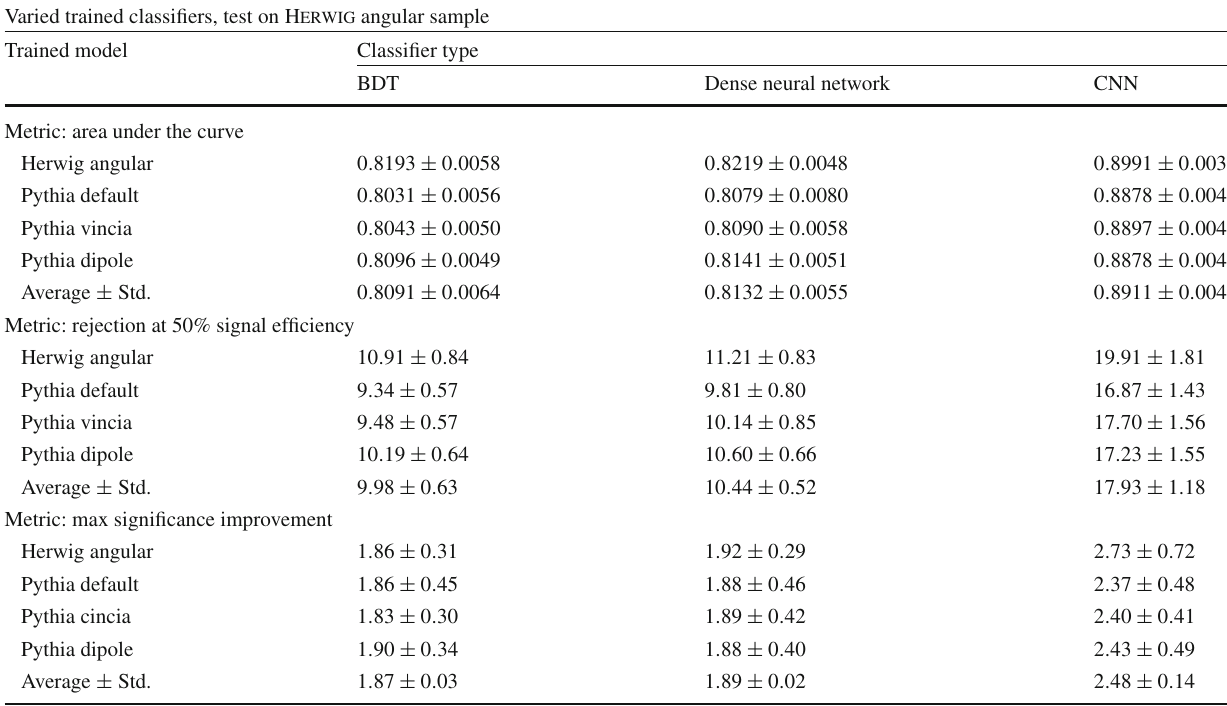
Table 1 Area under the curve, rejection at 50% signal efficiency and maximum significance improvement when testing on Herwig for each trained classifier. The last rows are the average and standard deviation over the mean values from the other rows Varied trained classifiers, test on Herwig angular sample